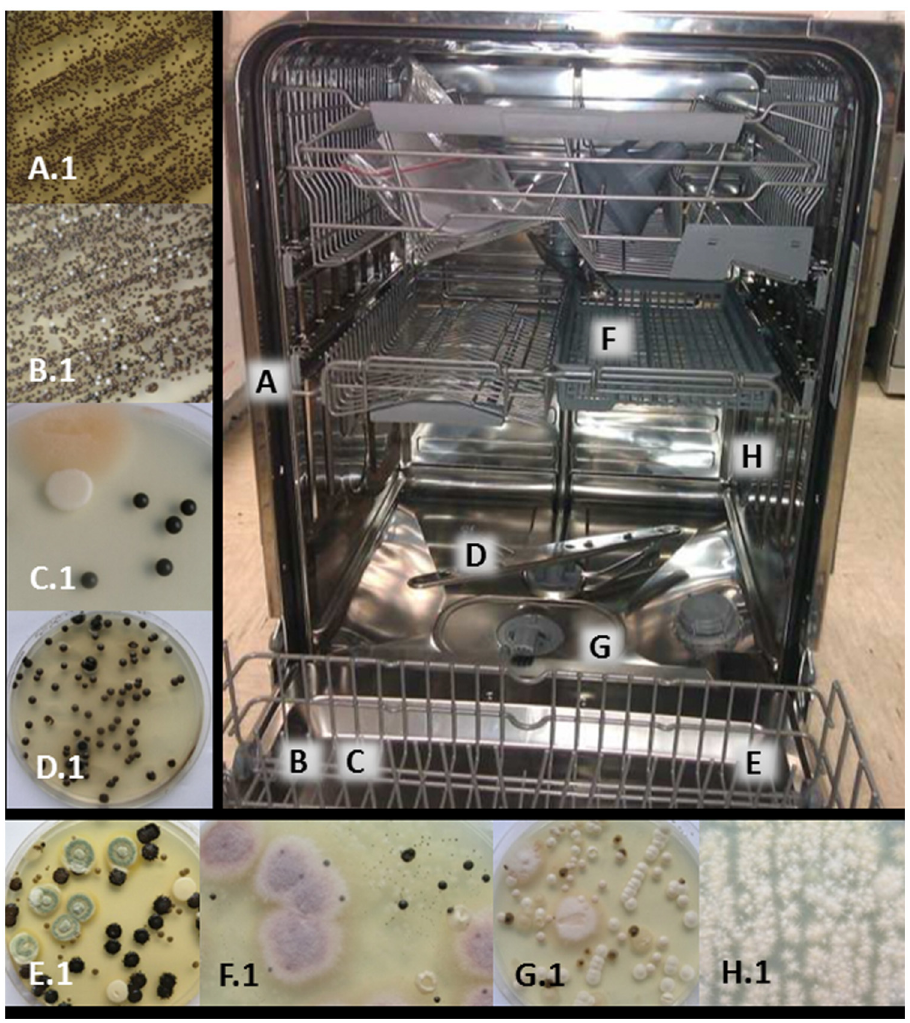
Fig 1. Sampling sites in the dishwashers (A-H) and the prevailing taxa on the primary isolation plates (A.1-H.1) cultured from the particular dishwashers sampling sites swab samples. On rubber seal (A) and detergent dispenser (B) E . dermatitidis genotype A (A.1, B.1, respectively ) ; on rinse-aid dispenser (C) E . dermatitidis genotype A, FDSC, Saprochaete/Magnusiomyces clade (C.1) ; on sprinkler (D) E . dermatitidis genotype A, E . phaeomuriformis genotype 1 (D.1) ; on door (E) A . melanogenum , P . crustosum , E . dermatitidis genotype A, C . parapsilosis (E.1) ; on cutlery rack (F) FOSC, E . phaeomuriformis genotype 1, C . parapsilosis (F.1) ; in drain (G) E . dermatitidis genotype A, Saprochaete/ Magnusiomyces clade, Meyerozyma guilliermondii , FDSC (G.1) ; on side nozzles (H) FDSC (H.1) . Note: not the actual state of one dishwasher, but a combination of several sampled